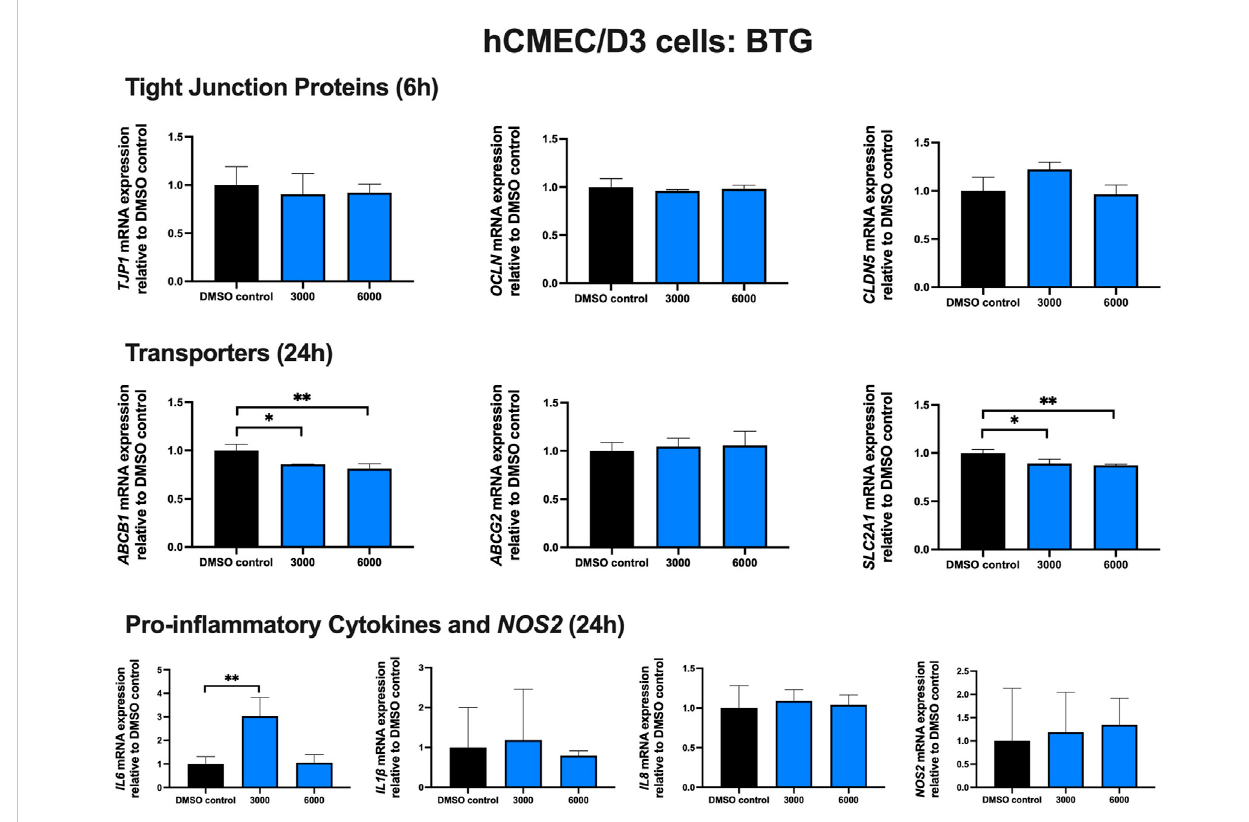
FIGURE 5 mRNA expression of TJ proteins, transporters, proin fl ammatory cytokines and NOS2 in hCMEC/D3 cells exposed to BTG (3,000, 6,000 ng/mL) or vehicle (DMSO) control for 6 or 24 h mRNA expression of TJP1, OCLN, CLDN5, ABCB1, ABCG2, SLC2A1, IL6, IL1 β , IL8 and NOS2 in hCMEC/D3 cells exposed to BTG relative to vehicle (DMSO) control was assessed by qPCR. Results are presented as mean relative mRNA expression ±SEM normalized to thehousekeepinghumancyclophilinBgenefrom n =4independentexperiments.One-wayANOVAwithBonferroni ’ spost-hoctest,*, p < 0.05;**, p <